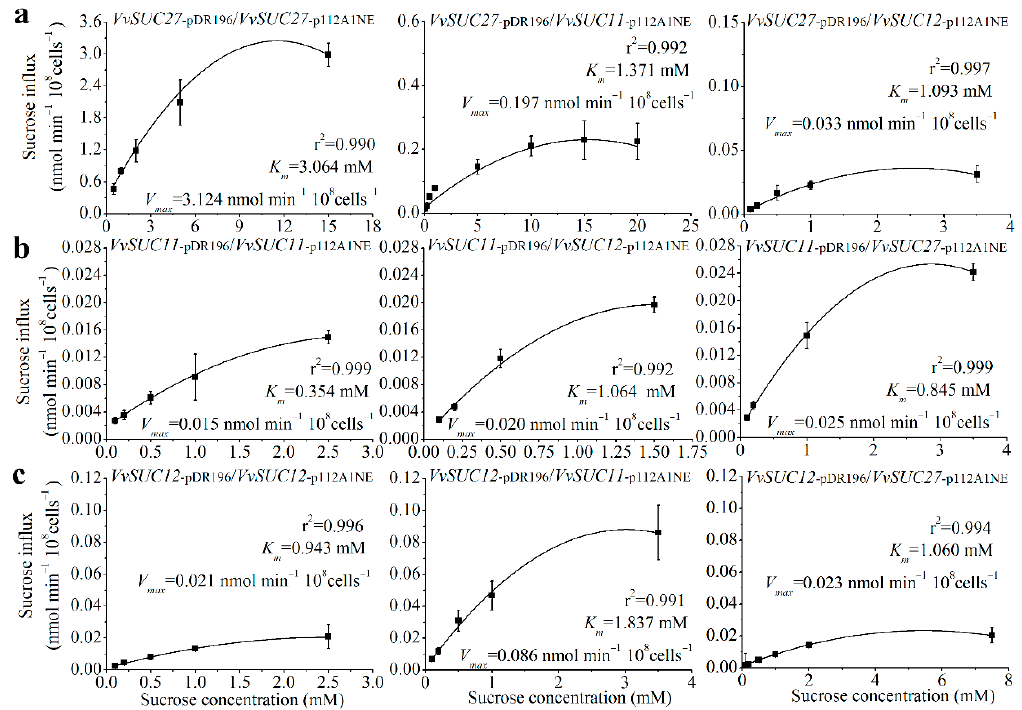
Figure 5. Sucrose uptake into yeast cells (SUSY7/ura3) was measured after co-expressing different VvSUC s. ( a ) VvSUC27 under the strong PMA1 promoter (pDR196) was co-expressed with each VvSUC driven by the weaker ADH1 promoter (p112A1NE). ( b ) VvSUC11 under the strong PMA1 promoter was co-expressed with each VvSUC driven by the weaker ADH1 promoter. ( c ) VvSUC12 under the strong PMA1 promoter was co-expressed with each VvSUC driven by the weaker ADH1 promoter. The error bar indicated mean ± SD ( n = 3).